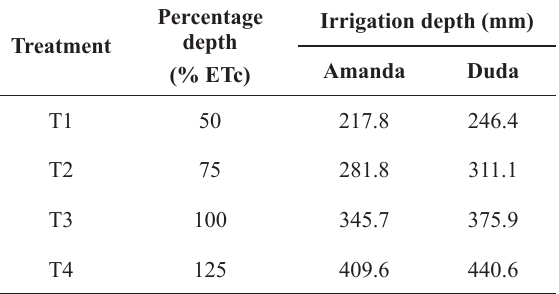
Treatments, percentage depth and irrigation depth for sweet potato cultivars Amanda and Duda